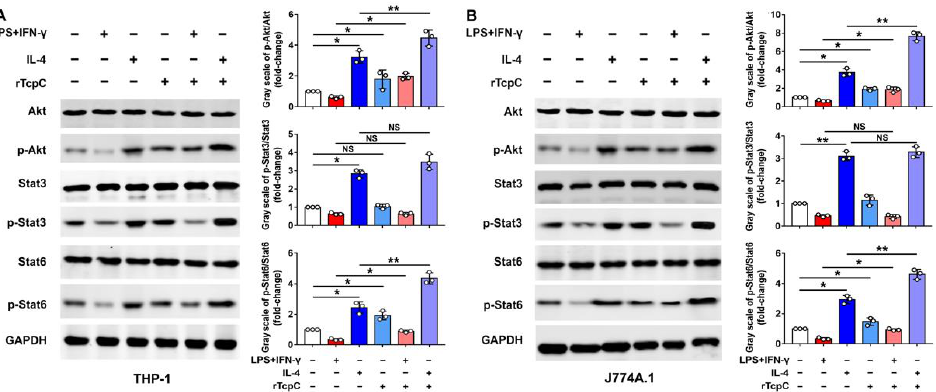
Figure 7. rTcpC promotes the activation of Akt/STAT pathway in macrophages. ( A ) Western blot analyses of the effects of rTcpC on phosphorylation of Akt, STAT3 and STAT6 and bands ’ gray-scale analyses in THP-1. ( B ) Western blot to examine the influences of rTcpC on phosphorylation of Akt, STAT3 and STAT6 and bands ’ gray-scale analyses in J774A.1. Mean ± SD of three independent experiments are shown. * : p < 0.05; ** : p < 0.01. NS: not significant.